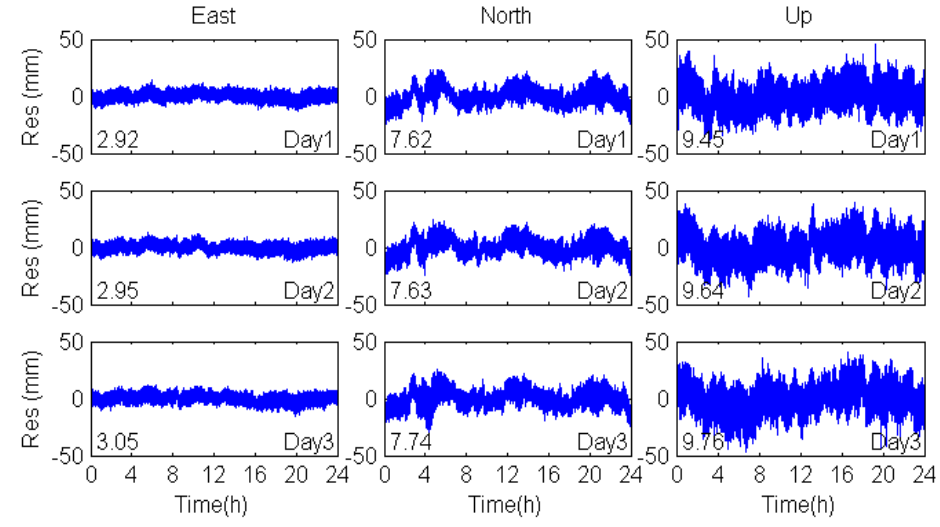
Figure 7. Residuals of the original coordinate sequences in the east, north and vertical coordinate directions. Numbers in the lower left corners are the RMS value of the coordinate residuals.